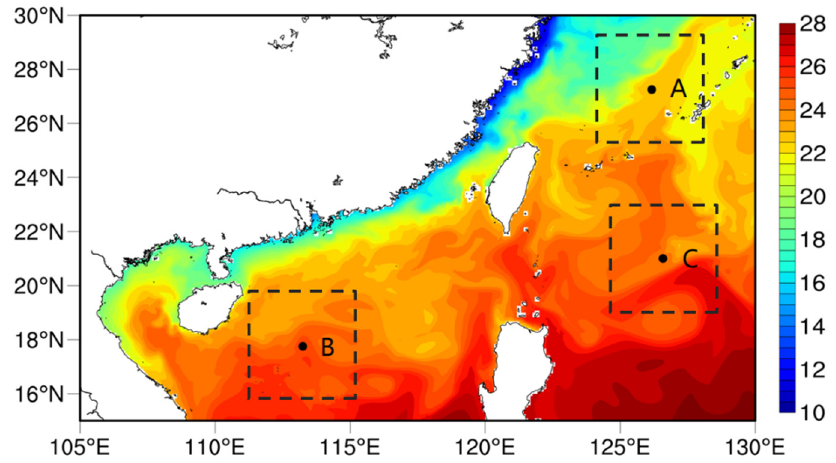
Figure 3. The locations of the group A, B, and C single-point experiments on 1 January 2015. The black box represents the study area within plus or minus 2° of the black dot, which was the observation point.